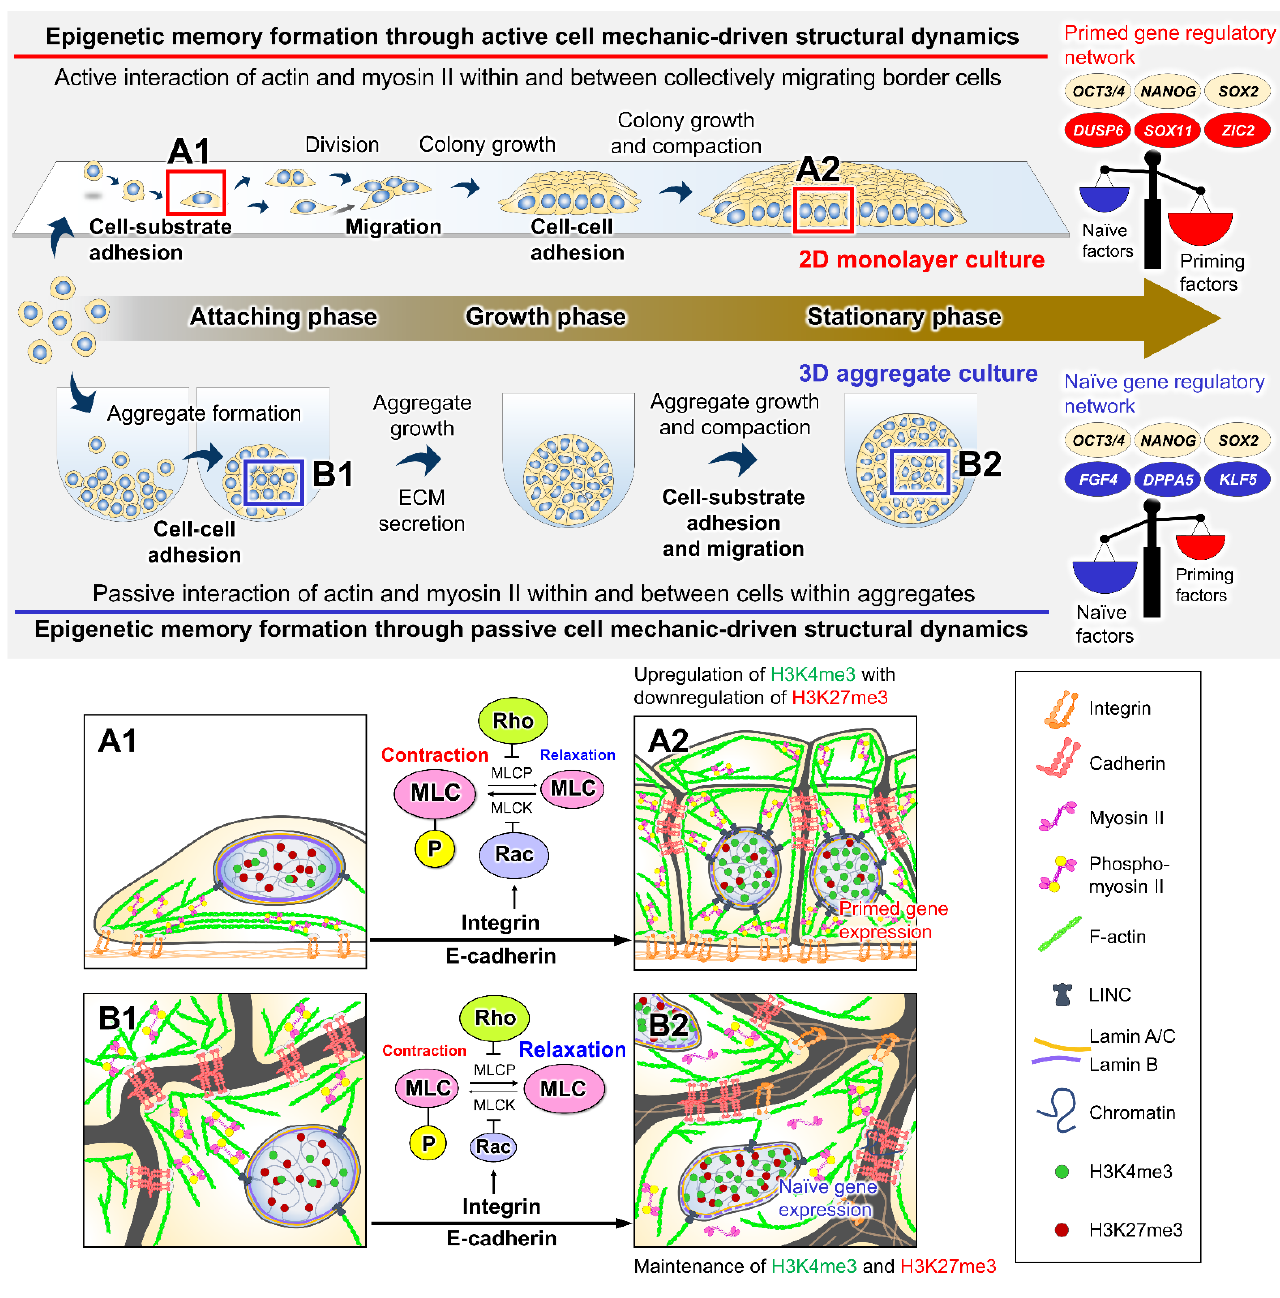
Figure 4. The impact of culture dimensionality on cell behavior-driven epigenetic memory. Cells adapt to different 2D and 3D culture conditions by modulating cell adhesion interactions and the balance of Rac/Rho GTPase antagonism [21,24,73]. In contrast to cells in 2D monolayers ( A1 , A2 ), cells in 3D aggregates interact with the surroundings in all dimensions and modify the actomyosin cytoskeletal contractility by altering myosin phosphorylation activity ( B1 , B2 ). The culture dimen- sionality and changes in force distribution within 3D structure potentially influence the maintenance of epigenetic memory and the distinctive transcriptional expression of naïve pluripotency-associated genes, consequently attuning the cellular pluripotency [24,74,78].